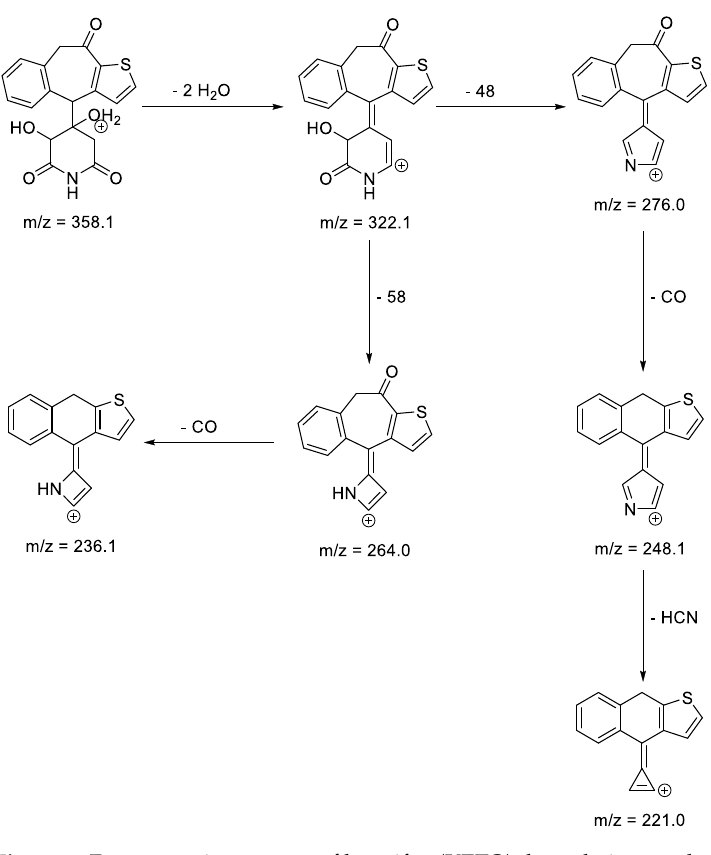
Figure 5. Fragmentation pattern of ketotifen (KETO) degradation product K-DP3.